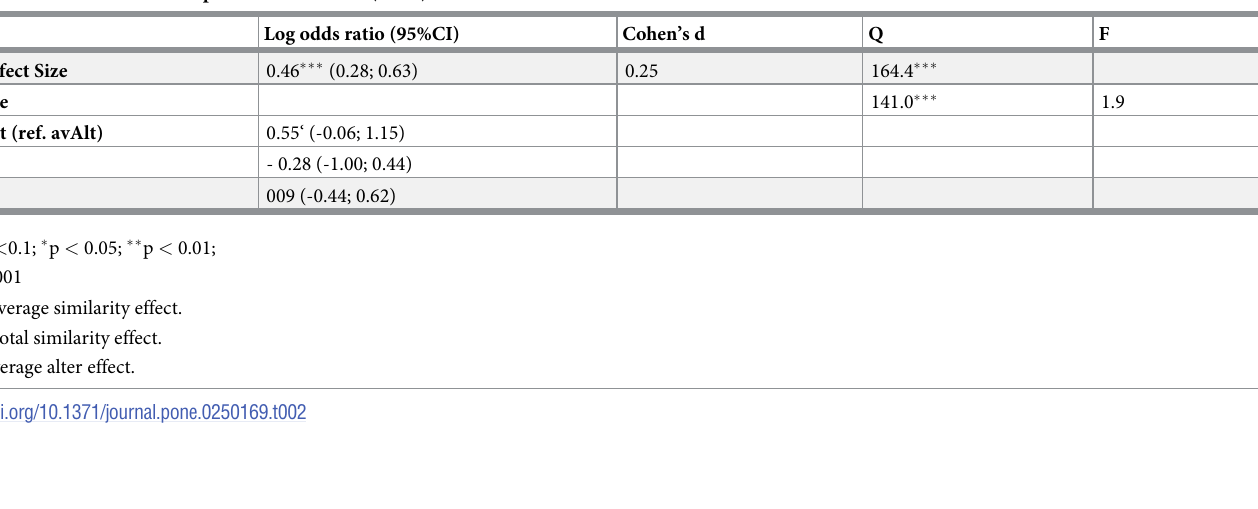
Table 2. Effect size estimates for peer selection effect